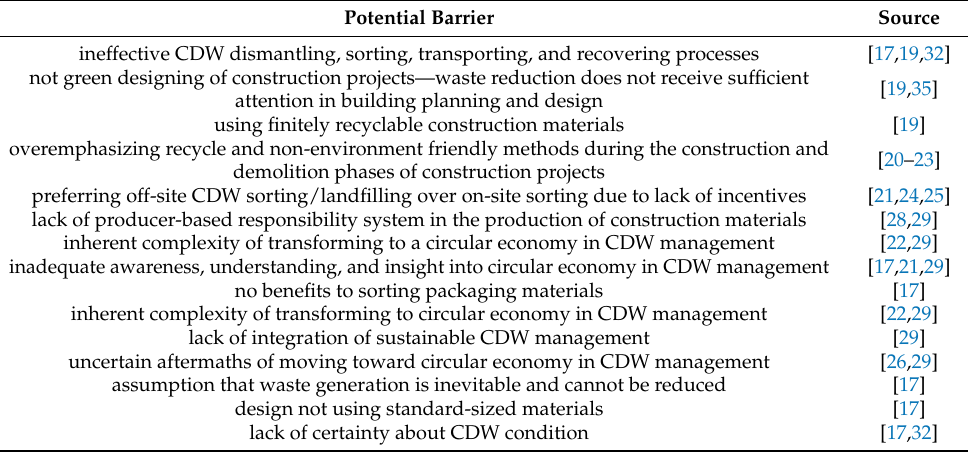
Table 1. Summary of environmental barriers to increasing construction and demolition waste (CDW) recycling and re-using.